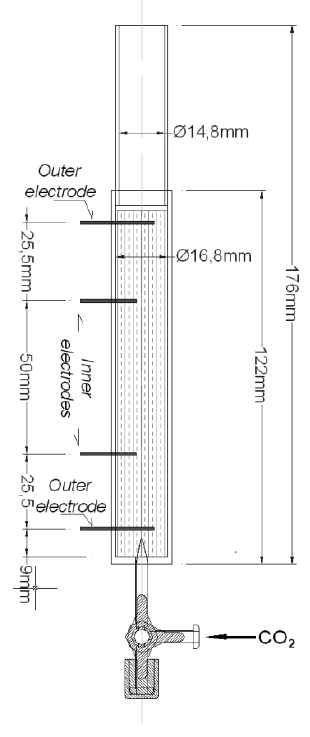
Fig. 3: Tetrapolar cell used in the carbon dioxide bubbling experiments. The CO2 was insufflated at the bottom of the cell.